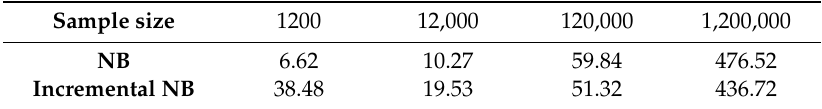
Table 3. Training time comparison (MS).